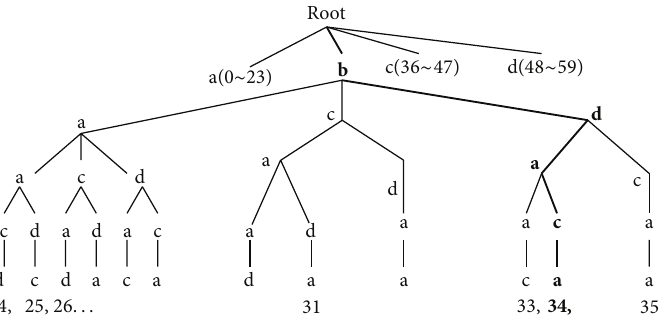
Figure 3: Quad tree which has “bdaca”.